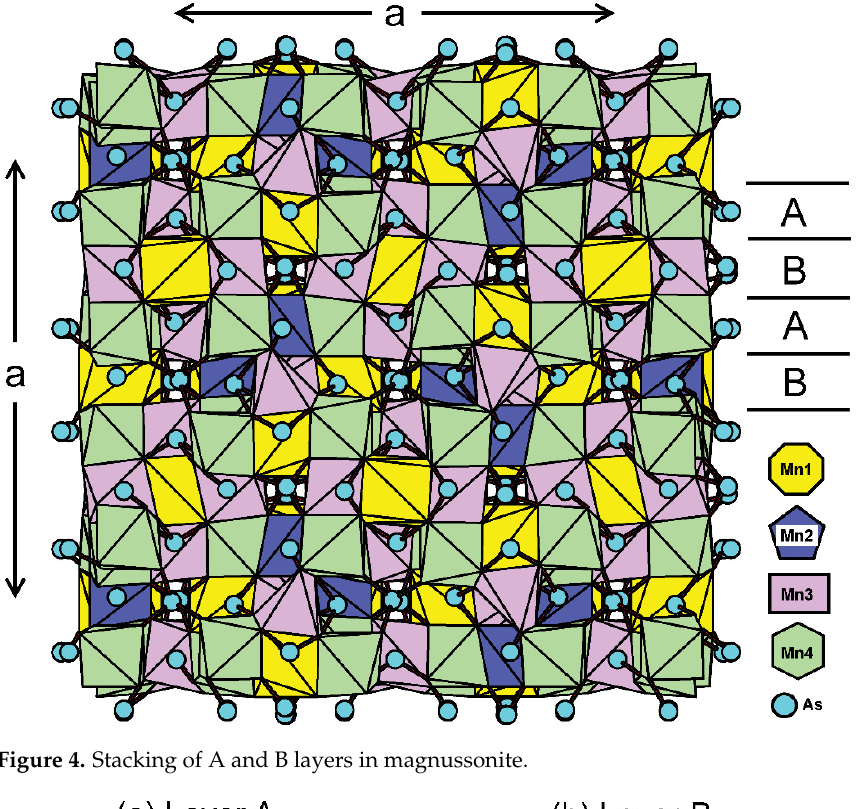
Figure 4. Stacking of A and B layers in magnussonite.